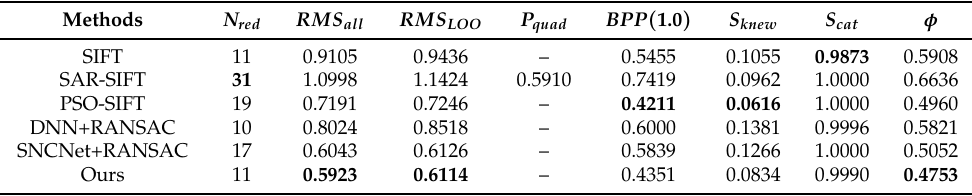
Table 2. The quantitative comparison among six methods on YellowR1 images.